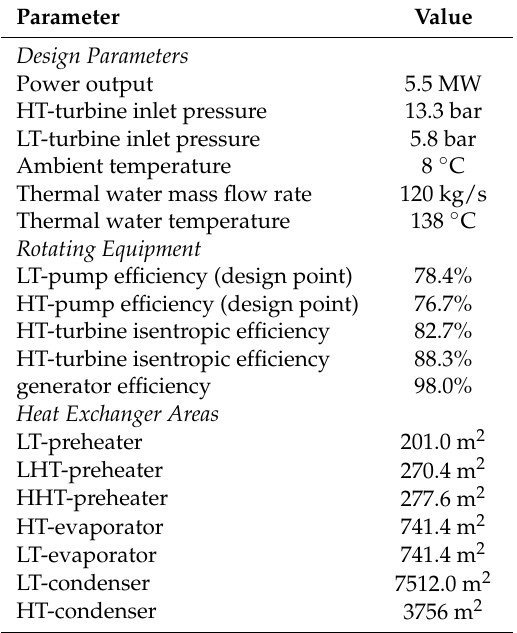
. H -diagram of the considered double-stage organic Rankine cycle. Figure 2. T - Figure 2. T - H (cid:4662) -diagram of the considered double-stage organic Rankine cycle. Table 3. Nominal parameters of the considered power Table 3. Nominal parameters of the considered power plant.